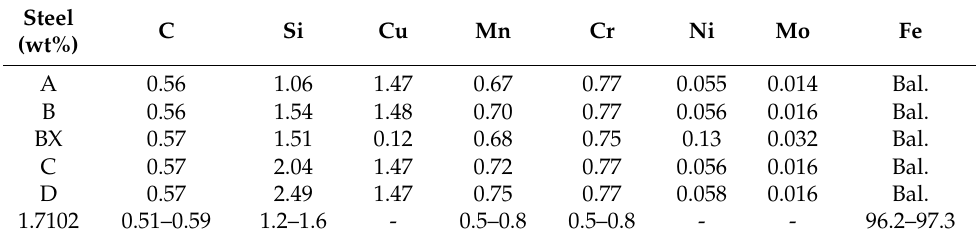
Table 1. Chemical compositions of the steels studied and 1.7102 steel,